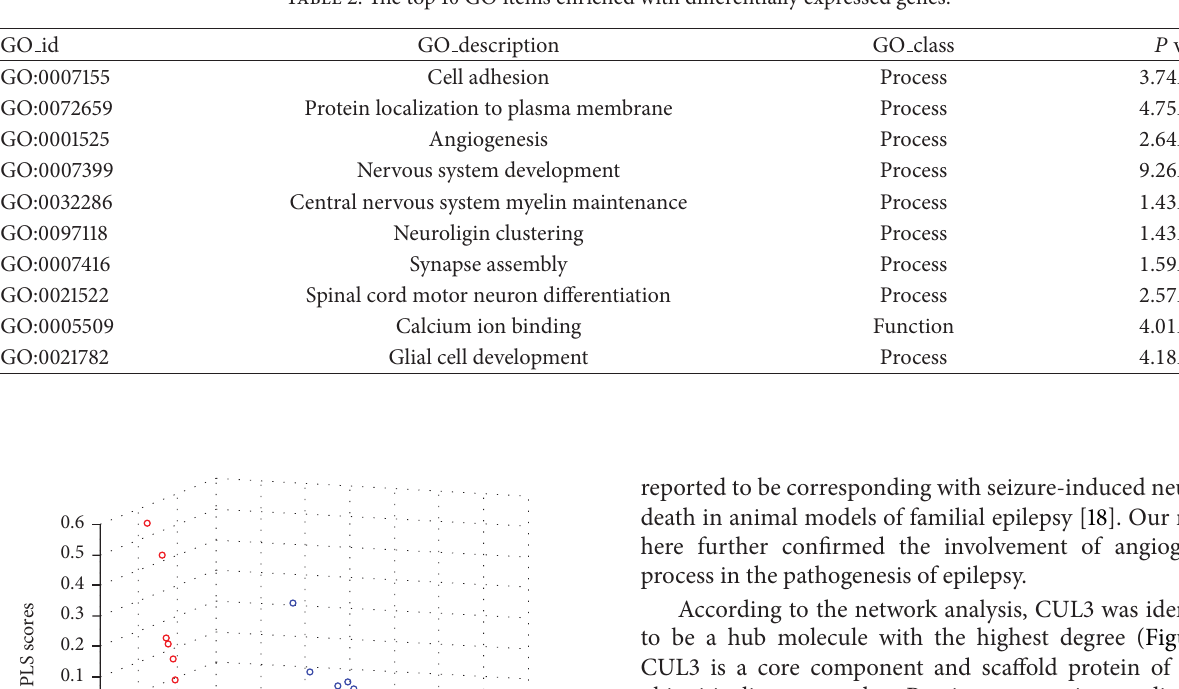
Table 2: The top 10 GO items enriched with differentially expressed genes.